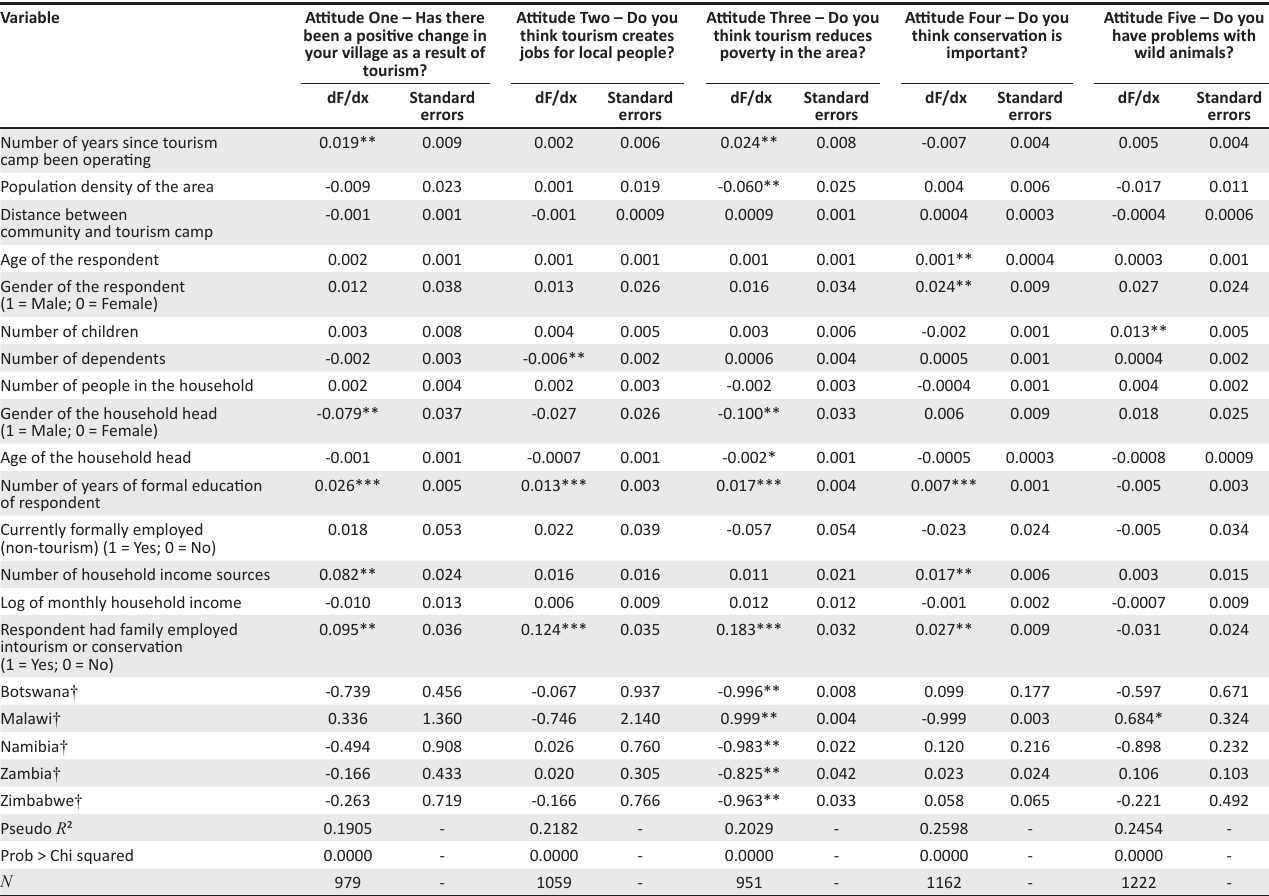
TABLE 5: Probit results reporting marginal effects for each attitude question. Variable